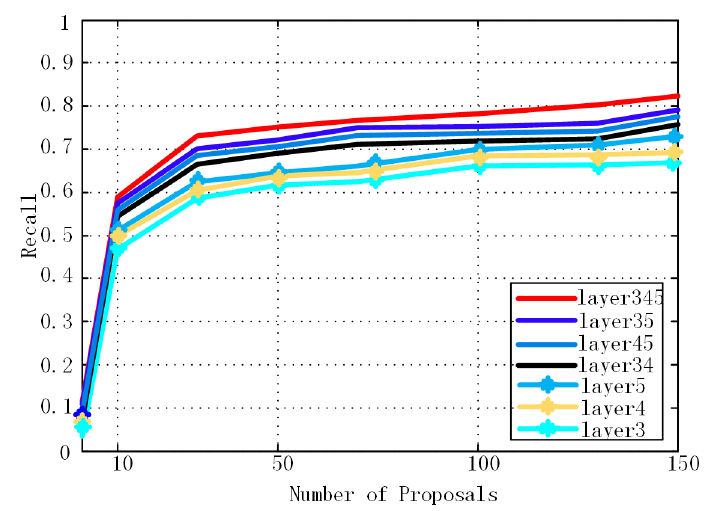
Figure 7. Recall versus number of proposals for different combining layers (IoU = 0.3). Table 3. Recall and mean average precision (mAP) with different